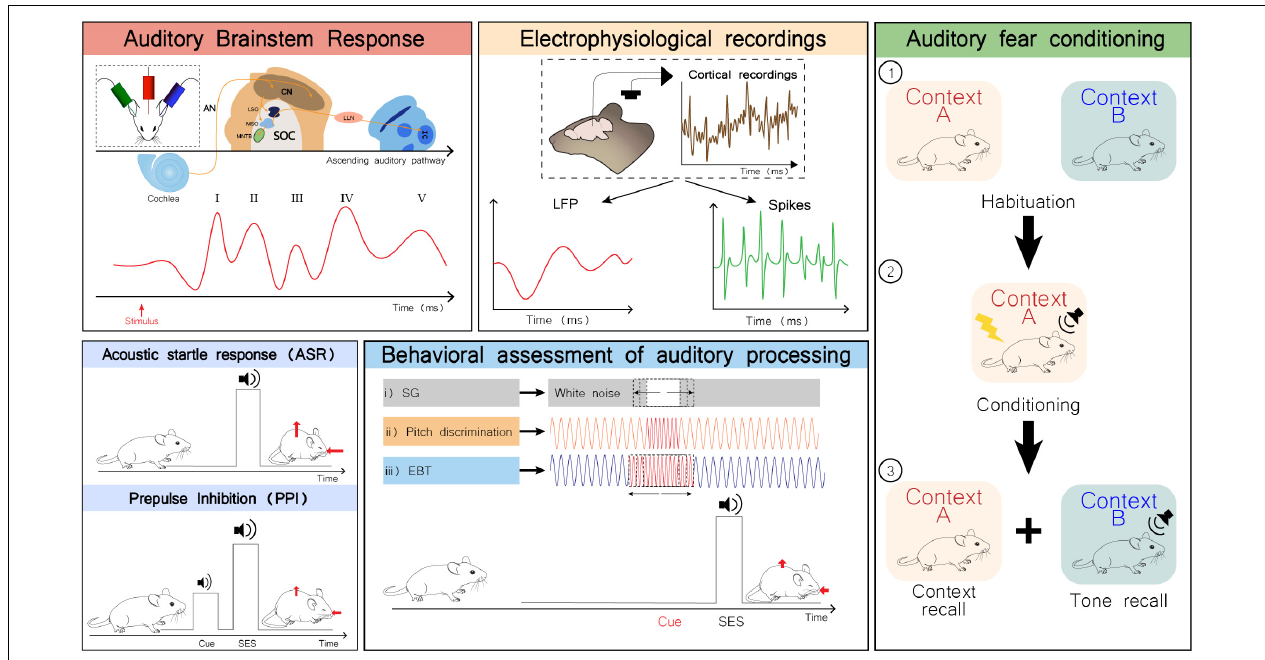
FIGURE 2 | Examples of some experimental approaches to study auditory alterations in rodents. Auditory brainstem response (ABR): Schematic representation of electrodes placement for ABR recording (inset; top left). Representation of the auditory pathway and corresponding ABR waves generated upon sound stimulation. Measuring ABR is a non-invasive to assess the sum of evoked potentials that occur in the first milliseconds after sound stimulation across the auditory system (Moller, 2006). Wave I is generated by signal propagation through the auditory nerve (AN), wave II through the cochlear nuclei (CN), wave III through the superior olivary complex (SOC), wave IV through the lateral lemniscus (LL), and wave V through the inferior colliculus (IC) (Knipper et al., 2013). LSO, lateral superior olive; MSO, medial superior olive; MNTB, medial nucleus of the trapezoid body. Electrophysiological recordings: Local field potentials (LFP) and spiking activity can be obtained from in vivo electrophysiological recordings in the auditory cortex. LFPs represent the summed activity of a certain population of neurons that is recorded in a specific region, while spiking refers to a single neuron activity. Acoustic startle response (ASR) and prepulse inhibition (PPI): The ASR is a short-latency response to a startle eliciting stimulus (SES), considered a defensive reaction to a strong and sudden stimulus that prepares the individual to face a potential threat. It is characterized by a rapid contraction of facial and skeletal muscles (red arrows). This response is preserved across mammalian species, involving the brainstem, and the auditory and vestibular systems. The PPI test evaluates the attenuation of the ASR by presentation of a non-startling stimulus immediately preceding the SES. This enables to quantitatively assess the sensory-motor gating function, and the ability to effectively filter sensory information, hence preventing sensory